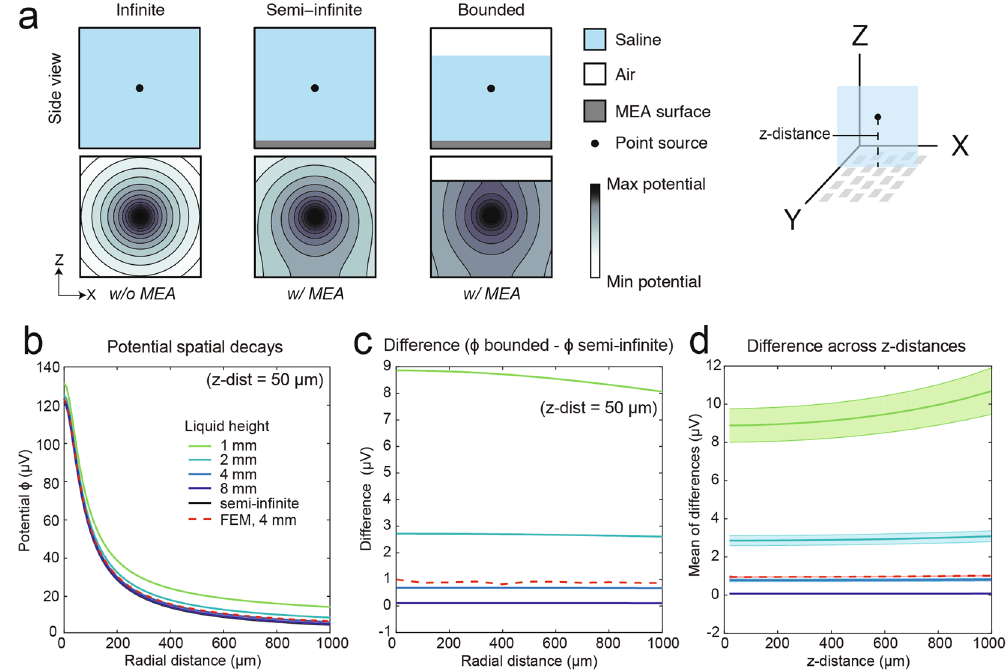
Figure 4. Saline column height introduces an approximately constant increase in potential across the MEA surface. ( a ) Overview of the method-of-images (MoI) models. The top panels show the model boundaries, wherein infinite has no boundary, semi-infinite has an insulating boundary at the bottom corresponding to the HD-MEA surface, and bounded has an additional insulating boundary at the top corresponding to the liquid- air interface. The bottom panels illustrate the radial electric potential distributions. The insulating boundaries massively influence the potential distribution and landscape. The magnitude of the electric potential, detected at the HD-MEA surface, was increased upon adding an insulating boundary (liquid-air-interface). ( b ) Potential spatial decays versus radial distance for a point source at a z-distance of 50 μ m, simulated for different liquid column heights (1, 2, 4, 8 mm and semi-infinite). The FEM result is also shown (red dashed line). The magnitude of the electric potential was highest for 1 mm liquid column height. ( c ) Difference in the electric potential spatial decays between bounded MoI (1, 2, 4, 8 mm) and semi-infinite MoI. The difference between FEM and semi-infinite MoI is also included. The potential increase in the bounded case is approximately constant along the radial distance on the HD-MEA surface. As the liquid height decreases, the difference in the potential spatial decays of MoIs (bounded - semi-infinite) increases. ( d ) The mean values and standard deviations of the differences were computed for z-distances between 10 and 1000 μ m and are represented as solid lines and shadowing. As the point source gets closer to the upper boundary, i.e., the liquid-air interface, the potential increases as indicated by the results for 1 mm liquid column height. All bounded MoI results include the grounding